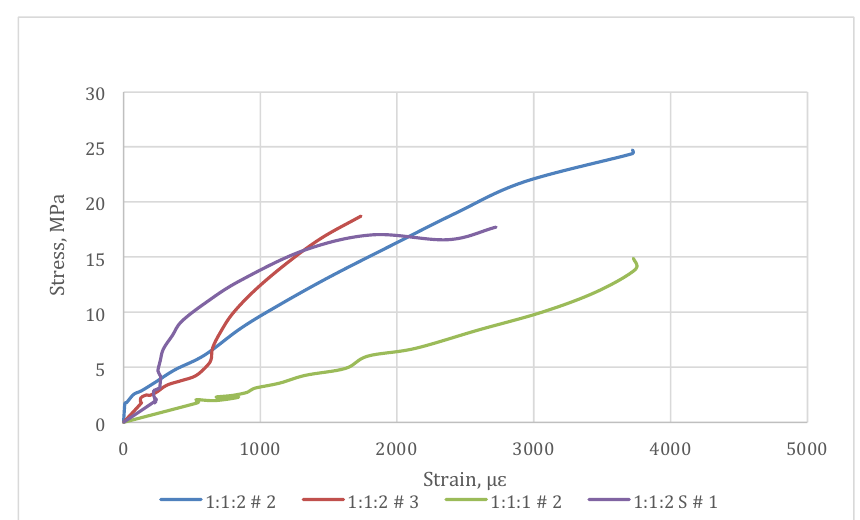
Figure 4. Stress Strain Diagram of Geopolymer Concrete.